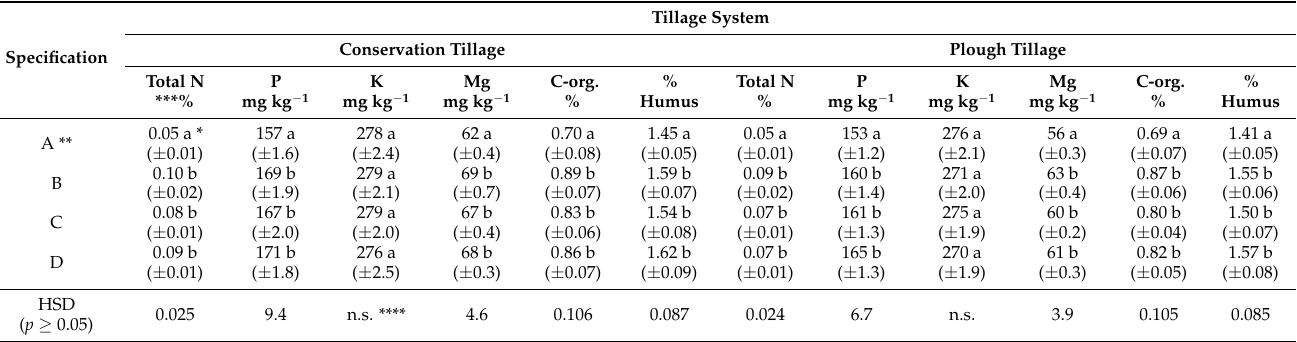
Table 6. Results of some chemical determinations for the plough layer (0–20 cm) in the experiment— mean for